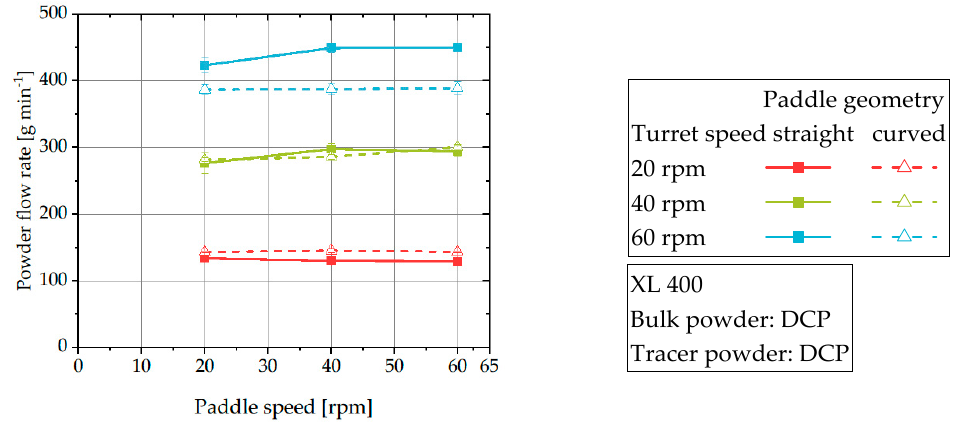
Figure 11. Powder flow rate of DCP at XL 400 for different process parameters.